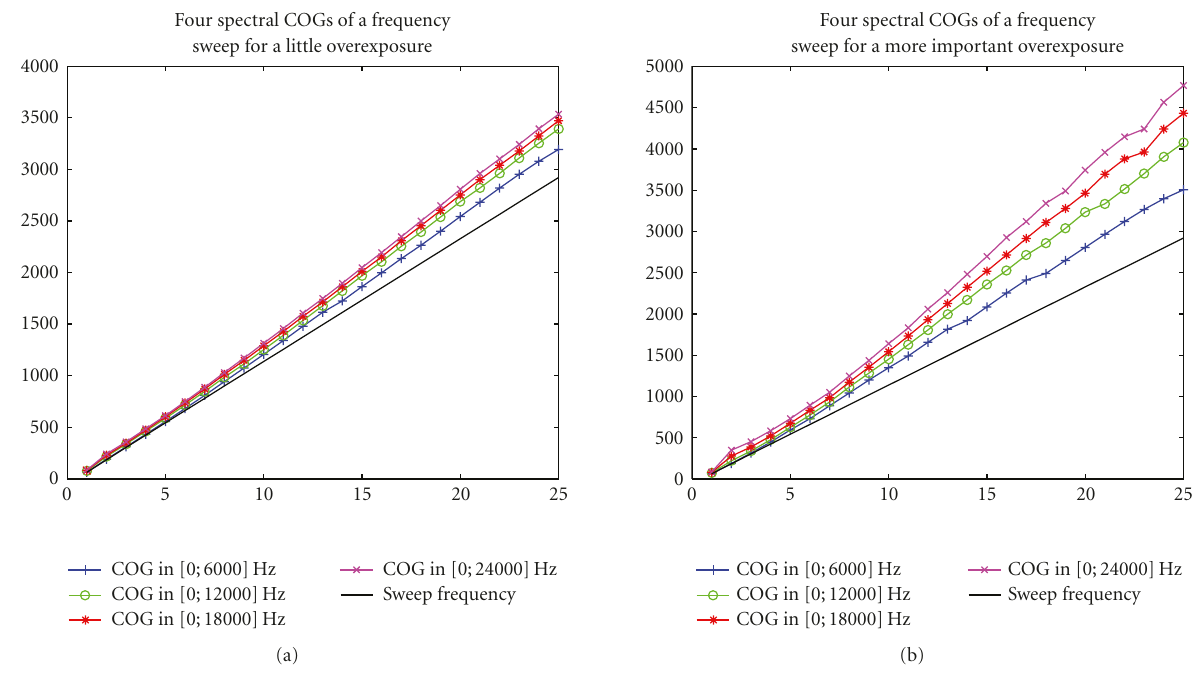
Figure 18: (a): COG calculation on the slightly altered sine sweep. All COG plots follow the fundamental frequency. (b): COG calculation on the sine sweep after simulation of a bad exposure. As expected, the raise of harmonics at increasing frequency shifts the COG to higher values.